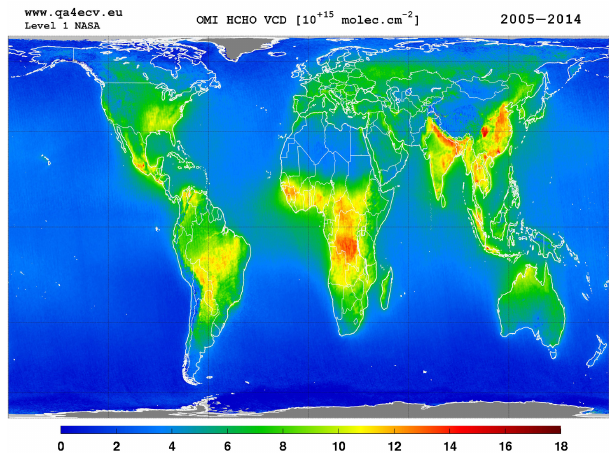
Figure 1. Ten-year average of HCHO vertical columns retrieved from OMI between 2005 and 2014 (http://www.qa4ecv.eu/ecv/